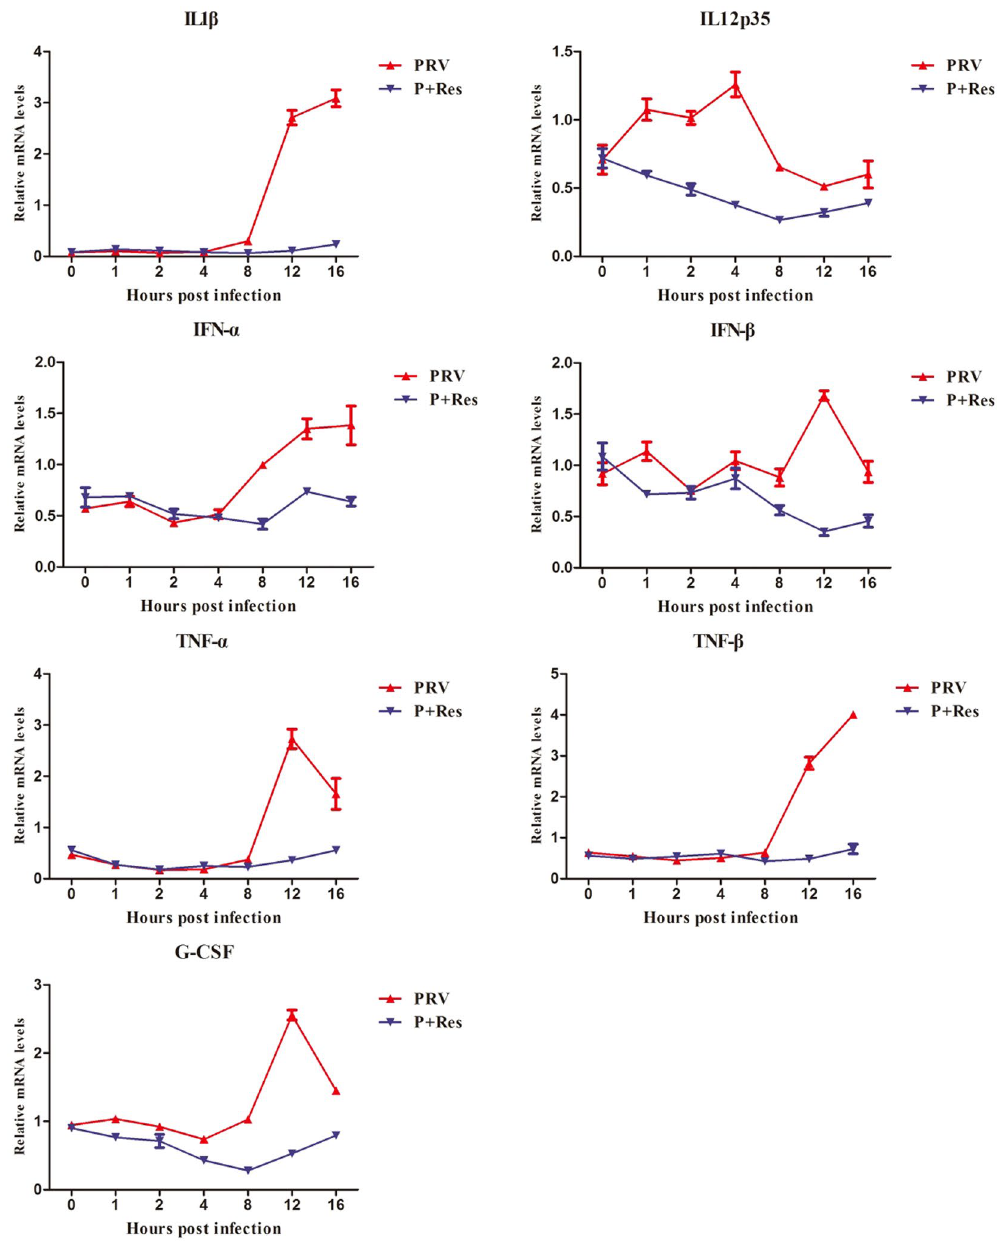
Figure 5. Res suppressed the expression of PRV-activated cytokine gene expression. Gene expression levels of activated cytokine genes in the presence or absence of Res (65.72 μ M) were assayed at 0, 1, 2, 4, 8, 12 and 16 hpi (n = 3, in each